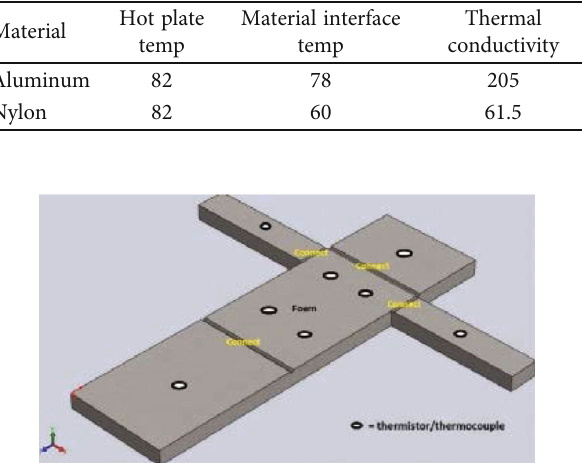
Figure 2: Picture of thermocouples implanted just underneath the furthest layer (reference [4]).